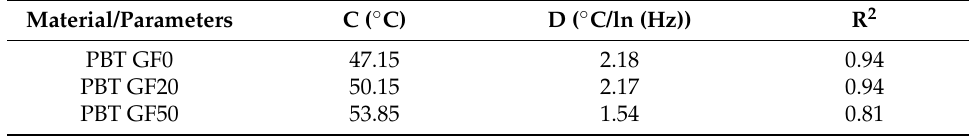
Figure 5. Variation in the glass transition temperature with frequency. Table 3. Defining parameters of T g evolution ( ◦ C) with